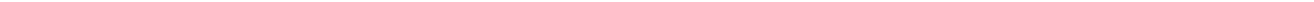
Fig. 2 Spondyloarthritis synovial fl uid T cells are highly enriched for GM-CSF production ex vivo. CyTOF viSNE clustering analysis of all live GM-CSF + events from paired ex vivo spondyloarthritis (SpA) synovial fl uid mononuclear cells (SFMC) a and PBMC b . In the top panels of a and b CD3, CD4, CD8, CD56, CD14 and CD20 are shown as the third parameter. The bottom panels of a and b show IFN- γ , IL-17A, IL-22, IL-4, IL-10 and TNF as third parameters. c Representative fl ow cytometry plots, gated on CD4 cells, from matched SpA patient PBMCs and SFMC showing IL-17A and GM-CSF production. d – e Flow cytometry data of 5 matched ex vivo SpA PBMC d and SFMC e samples showing the mean cellular components of the GM-CSF pool. f Paired PBMC and SFMC fl ow cytometry data gated on CD4 showing the percentage of IL-17A + GM-CSF − , IL-17A − GM-CSF + and IL-17A + GM-CSF + in SpA patients ( n = 5, paired t -test). g Paired PBMC and SFMC fl ow cytometry data showing the percentage of IL-17A + GM-CSF + CD8 cells in SpA ( n = 5, paired t